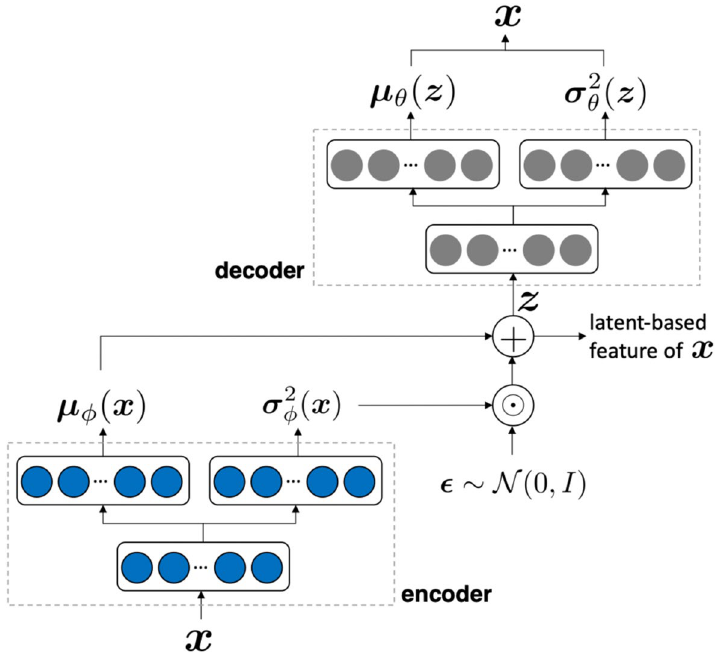
Fig. 10 Variational autoencoder (from Nishizaki